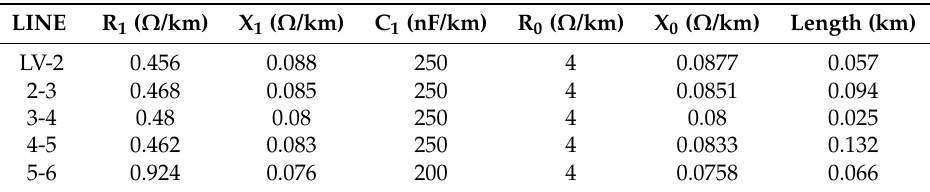
Figure 3. Feeder topology used to access the performance the examined control strategies. Table 1. Properties of the LV